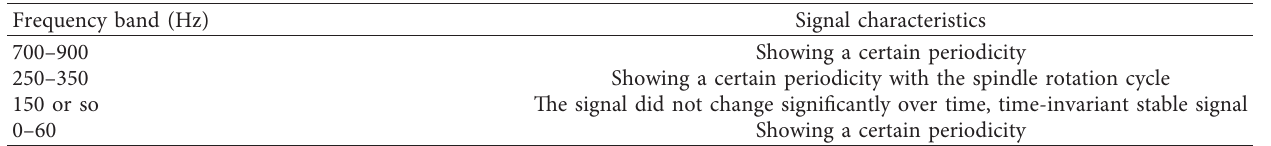
Figure 4: Time-frequency of the noise signal. Table 2: The signal characteristics of each frequency